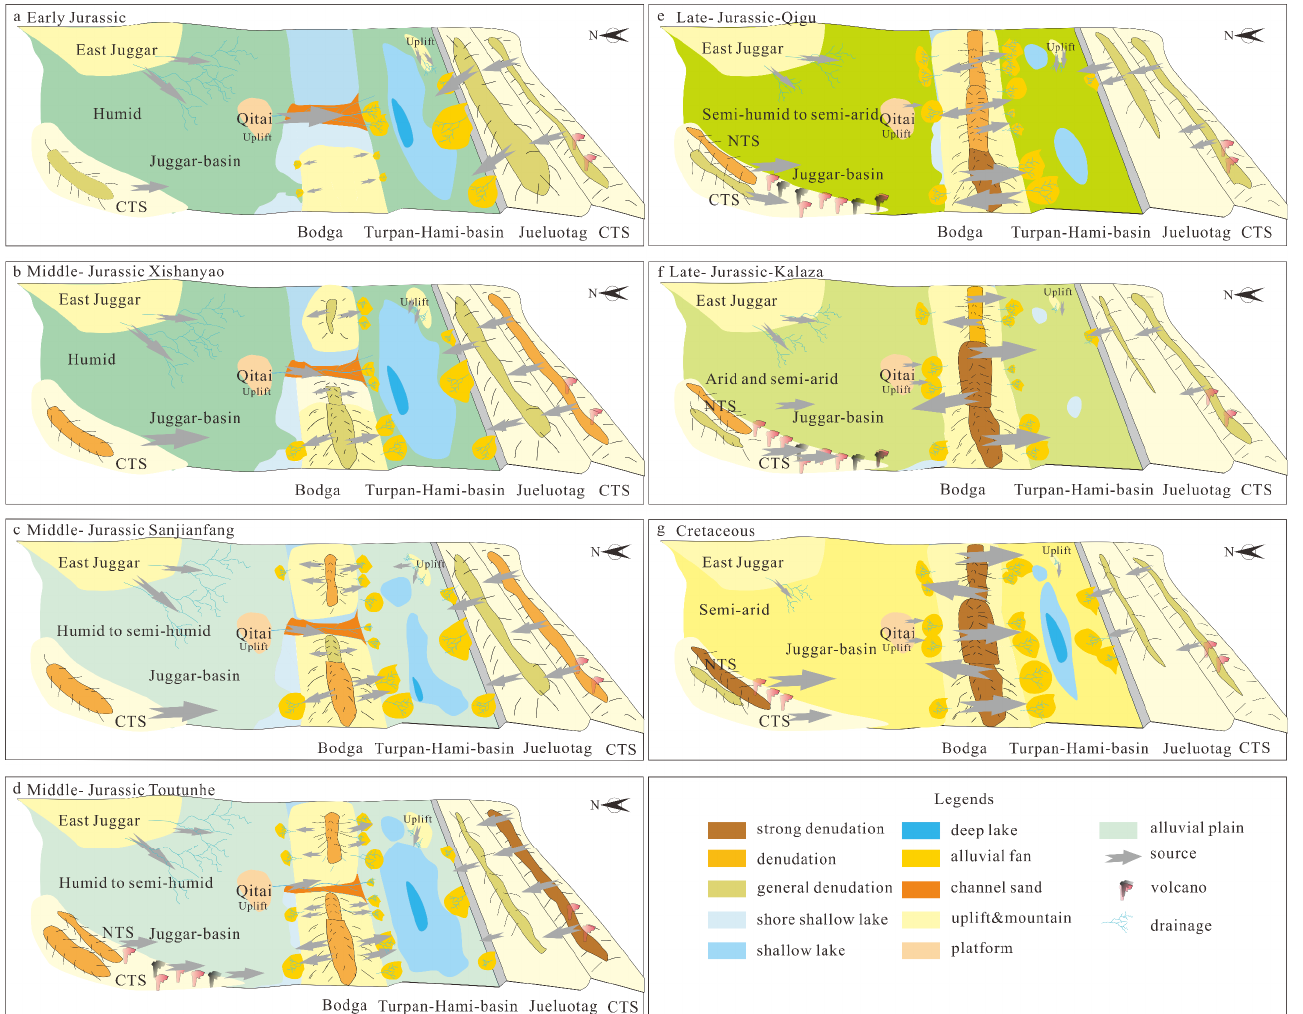
Figure 18. Schematic diagrams (not to scale) illustrating the tectonic evolution of the Turpan-Hami basin and its adjacent regions during the Jurassic–Cretaceous; ( a ) Early Jurassic; ( b ) Middle Jurassic- Xishanyao; ( c ) Middle Jurassic Sanjianfang; ( d ) Middle Jurassic Toutunhe; ( e ) Late Jurassic Qigu; ( f ) Late Jurassic Kalazha; ( g ) Cretaceous.